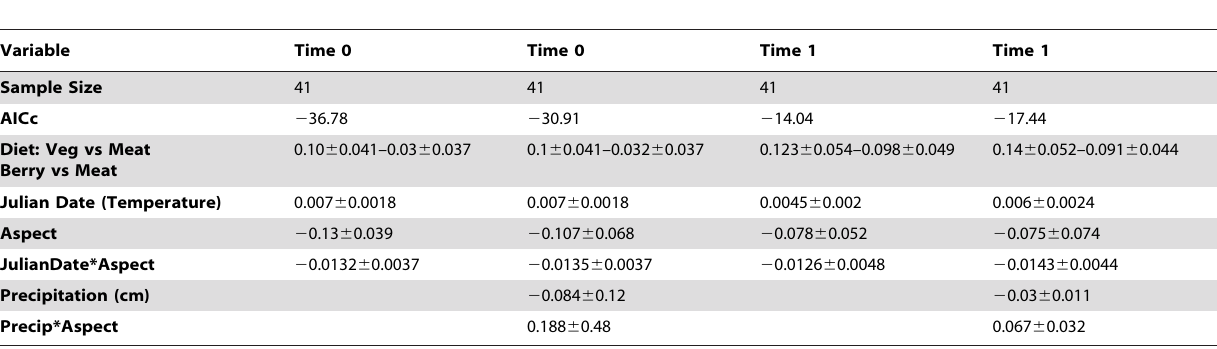
Table 1. Model estimates and standard errors for impacts of diet, Julian date, aspect, and precipitation on glucocorticoid concentrations [log10(x + 1)] in fresh bear fecal samples collected in Glacier National Park, Montana.